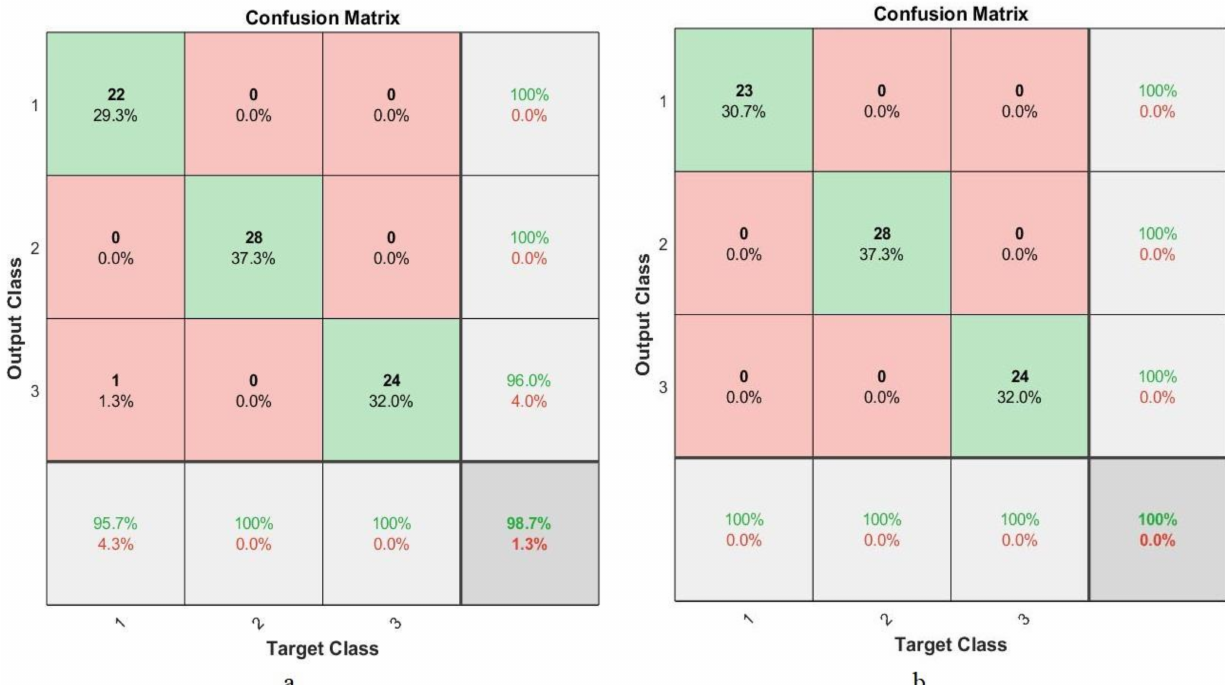
Figure 13. The confusion matrix for the FFNN classifier in the classification of images of the second dataset based on mixed features: ( a ) DenseNet-121 and hand-crafted; ( b ) ResNet-50 and hand-crafted.